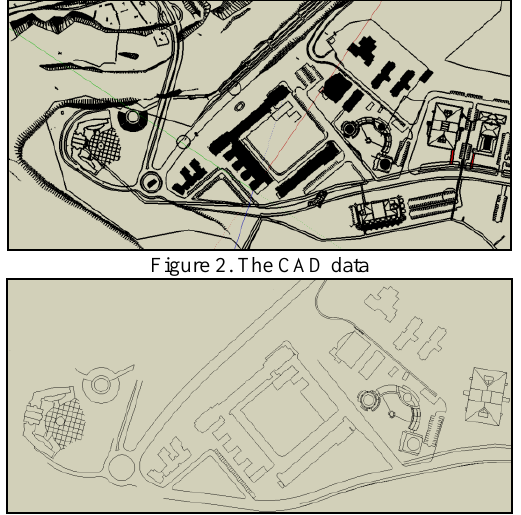
Figure 3. Simplified and generalized CAD data